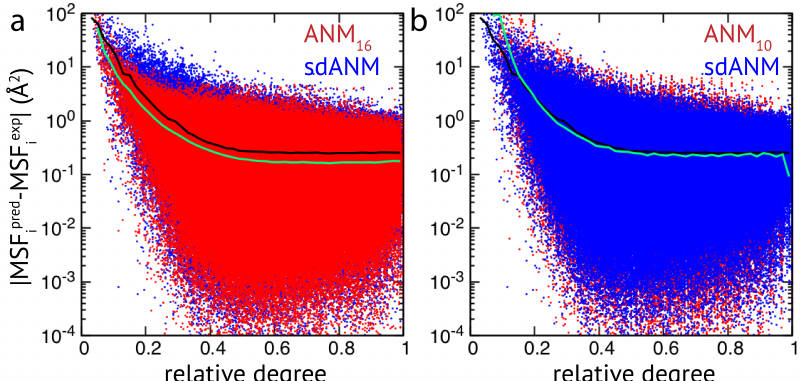
Figure 2. Extensive analysis of predictions by ENM variants. The error in MSF prediction for a set of more than 2000 protein structures is shown (in logarithmic scale). Each data point represents the absolute deviation of predicted and experimental MSF obtained for a single residue bead in a protein elastic network, as a function of its relative degree. ( a ) Red dots are obtained for ANM 16 and blue dots correspond to sdANM predictions. ( b ) ANM 10 is compared with sdANM. In both plots, the average absolute errors are indicated as black lines for sdANM and as green lines for